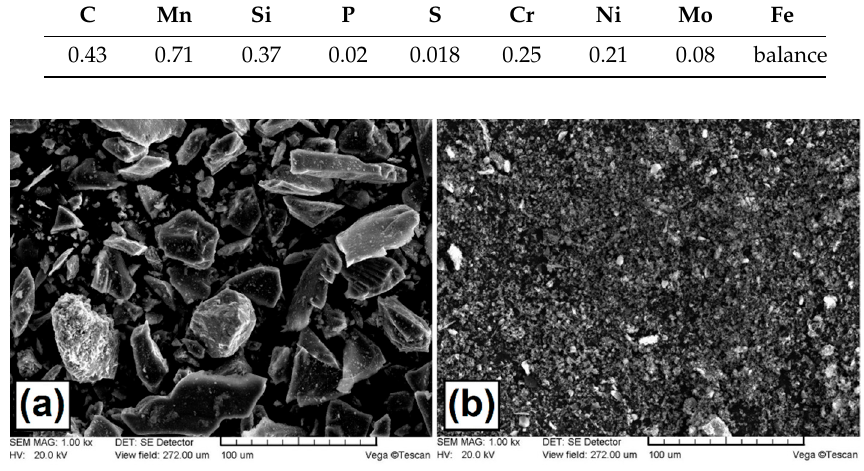
Figure 1. Morphology of powders used: ( a ) silicon particles; ( b ) boron particles.